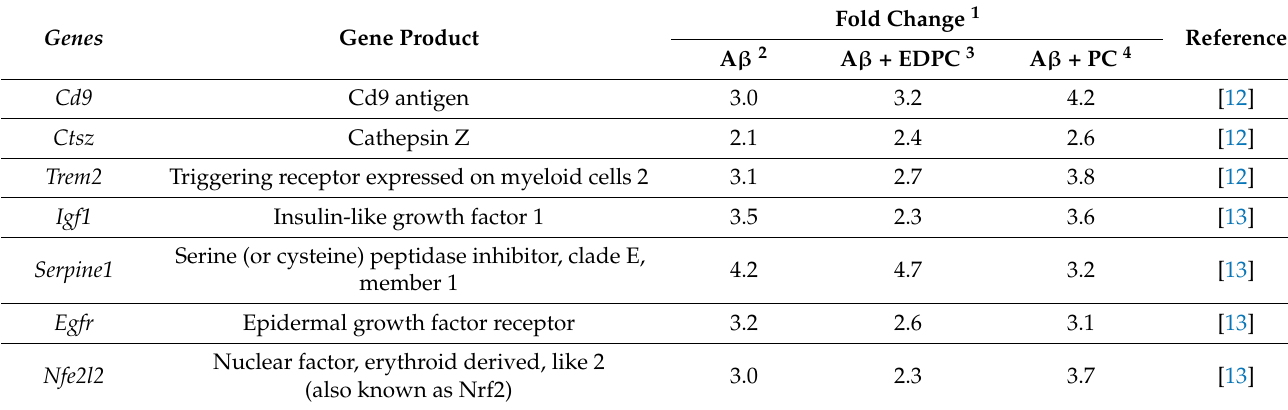
Table 2. Upregulated A β -related genes were also upregulated in similar AD models.